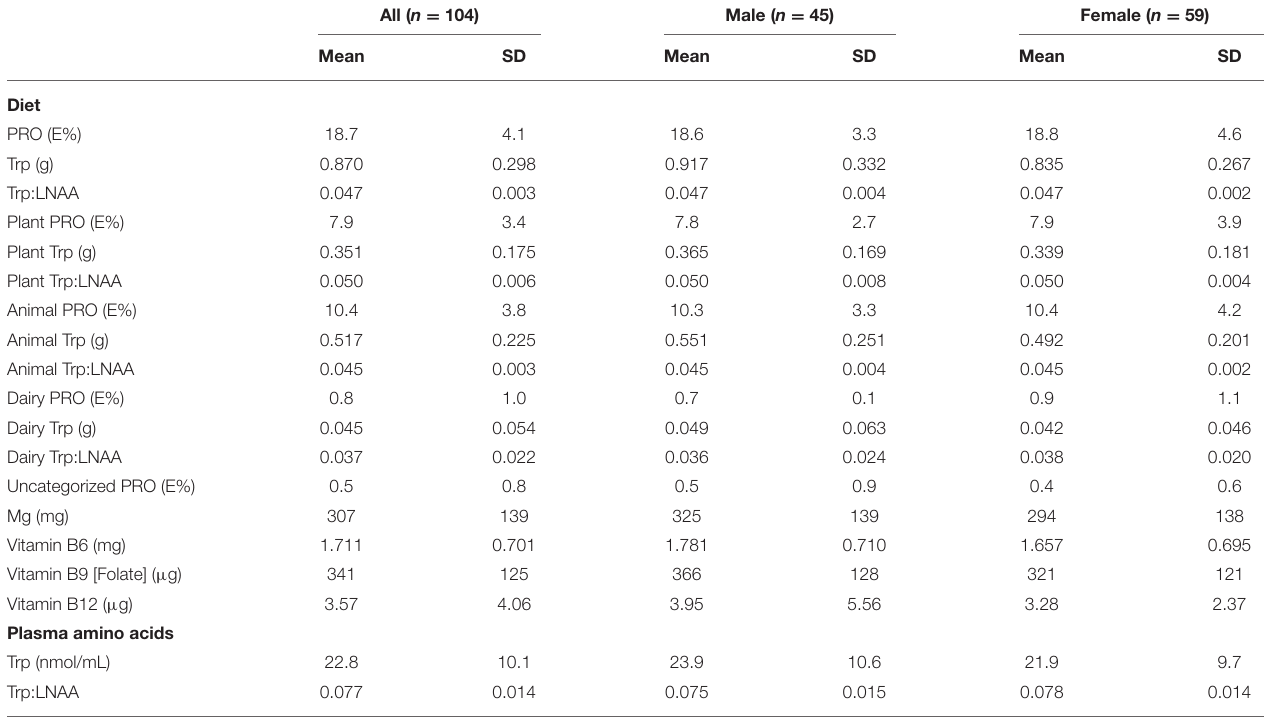
TABLE 3 | Nutrient intakes and plasma amino acids concentration.